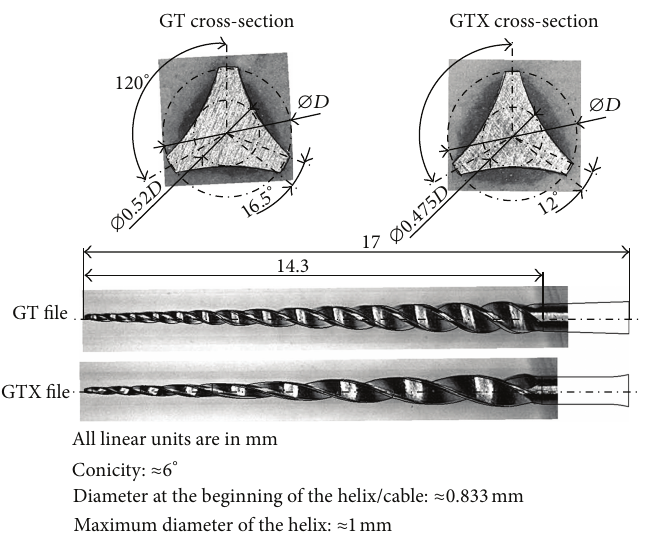
Figure 1: Cross-sectional and longitudinal geometries of the GT and GTX file instruments used in this study, where 𝐷 stands for the local